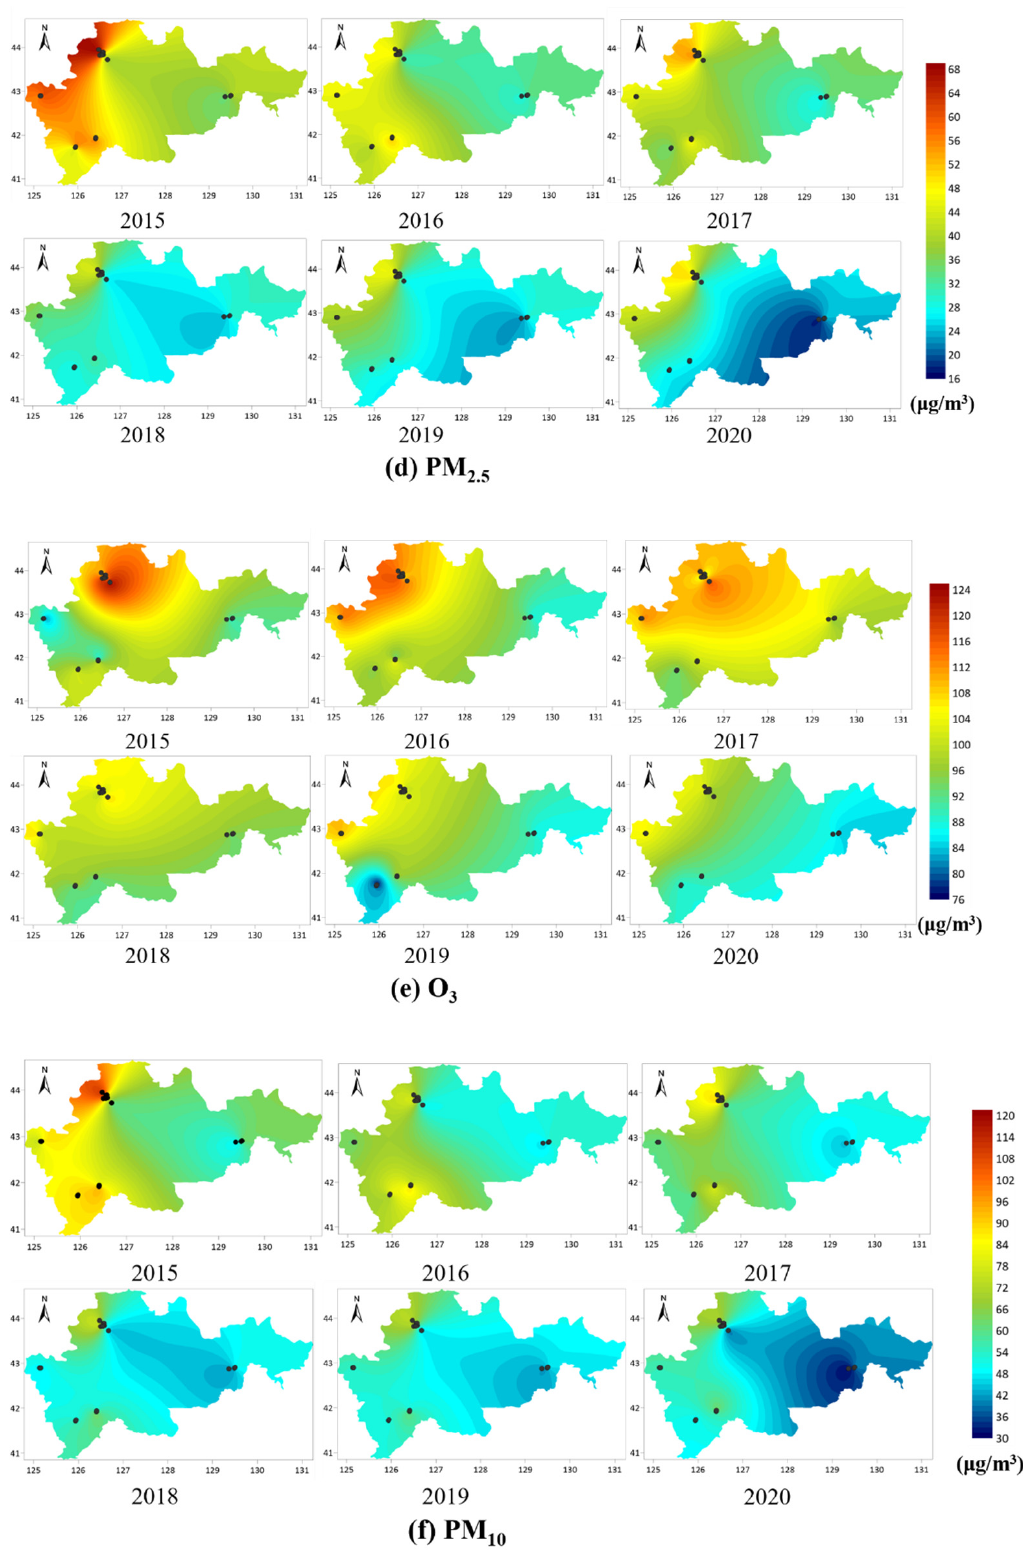
Figure 3. Spatial distribution of annual average concentrations of six pollutants in the eastern Jilin Province, China, from 2015 to 2020. ( a ) CO unit: mg/m 3 ; ( b ) SO 2 unit: μ g/m 3 ; ( c ) NO 2 unit: μ g/m 3 ; ( d ) PM 2.5 unit: μ g/m 3 ; ( e ) O 3 unit: μ g/m 3 ; ( f ) PM 10 unit: μ g/m 3 . (The black dot on the figure is the position of the monitoring point).